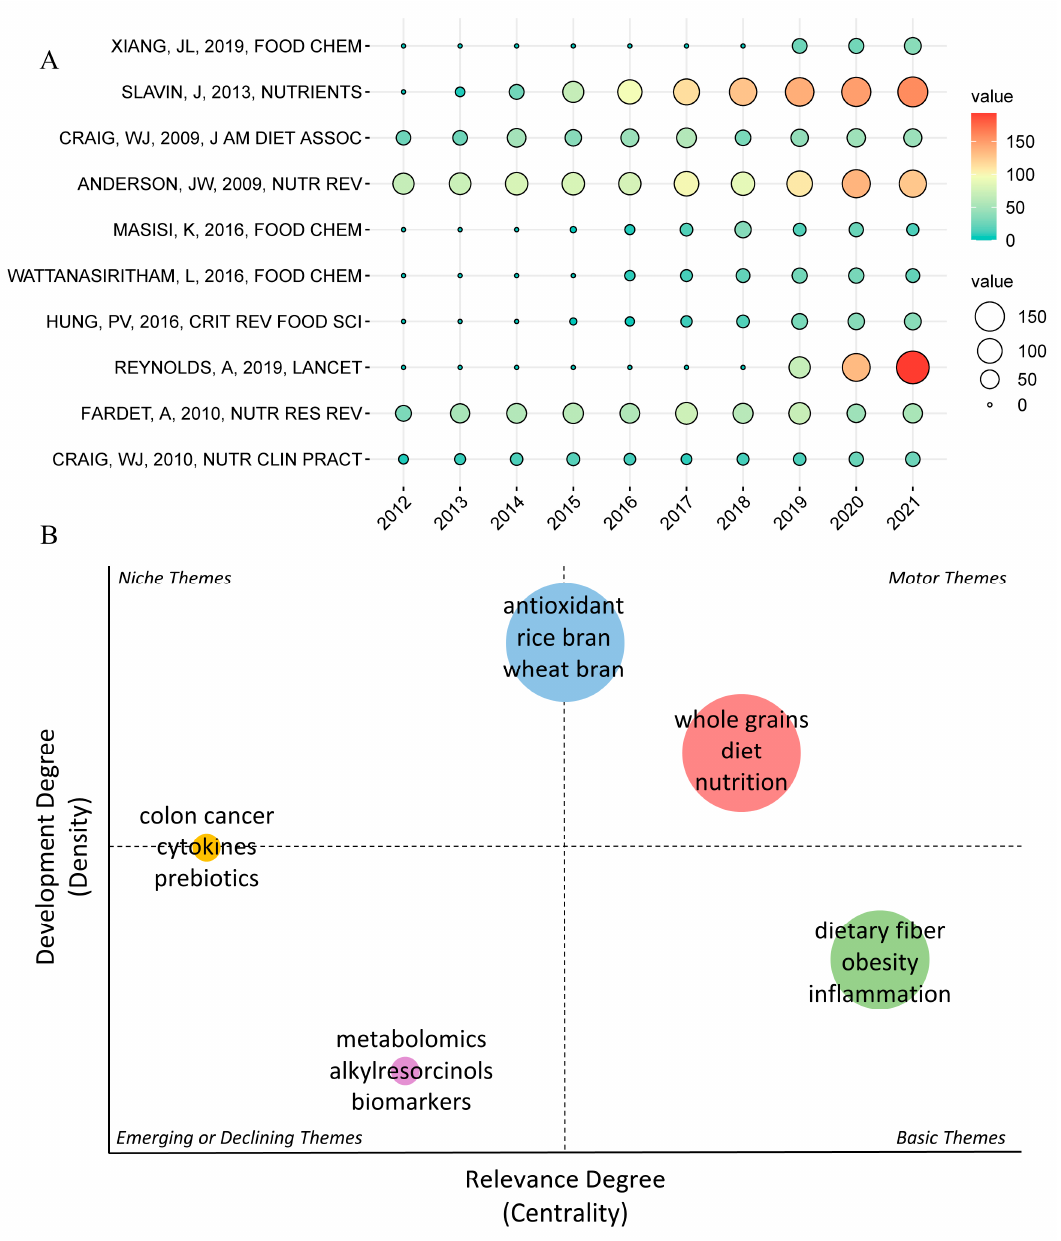
Figure 5. Evolution of research trends. ( A ) Top 10 publications by usage count over the last ten years. The size and colors of the circle represent the citations of papers. ( B ) Thematic map.